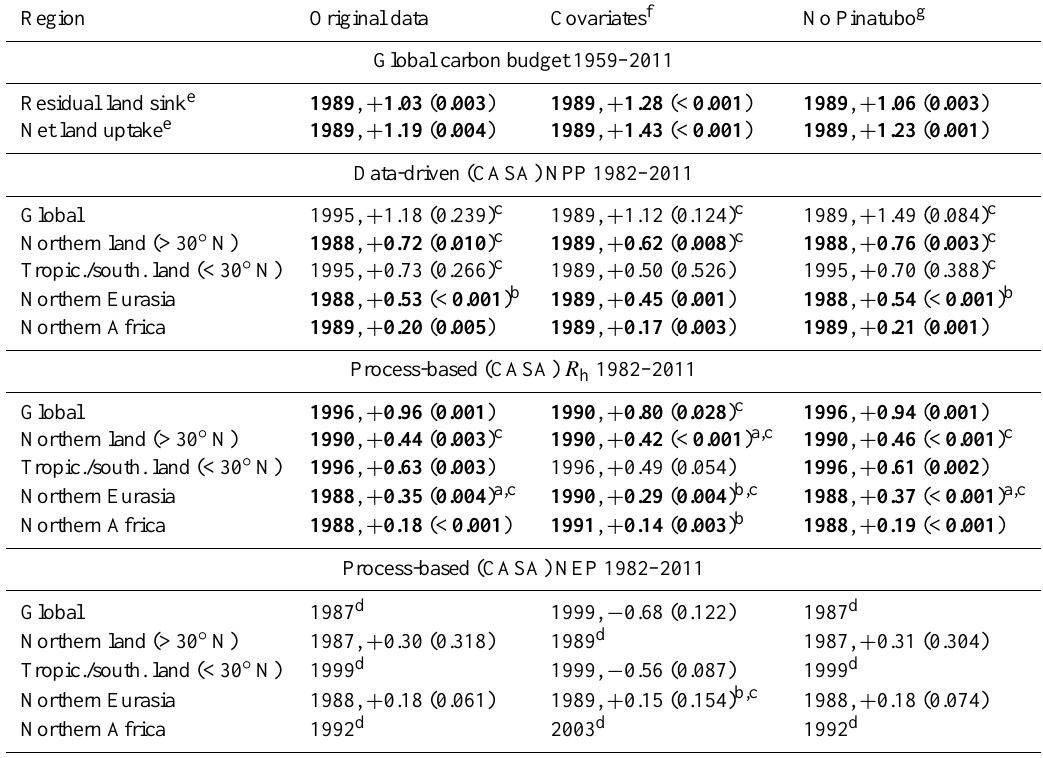
Table 1. Timing and magnitude of abrupt changes in the terrestrial carbon cycle at global and continental scales. Timing of abrupt change (first data entry) as well as corresponding direction and magnitude (second data entry in units of PgCyr − 1 ) and P values (in brackets; estimated through Monte Carlo simulations) are provided if a shift-in-the-mean model fits the respective time series best (see Sect. 2). The timing of a shift indicates the first year of a new regime. Shifts that are statistically significant ( P <0.05) are highlighted in bold. Additional tests were carried out to assess the nature and robustness of the shifts, including accounting for influences related to ENSO and volcanic eruptions (Covariates), and specifically removing the two years of largest impact of the strong Mt. Pinatubo volcanic eruption in the original time series (no Pinatubo). Plots of all time series analyzed are also provided (Figs. S2–S3).